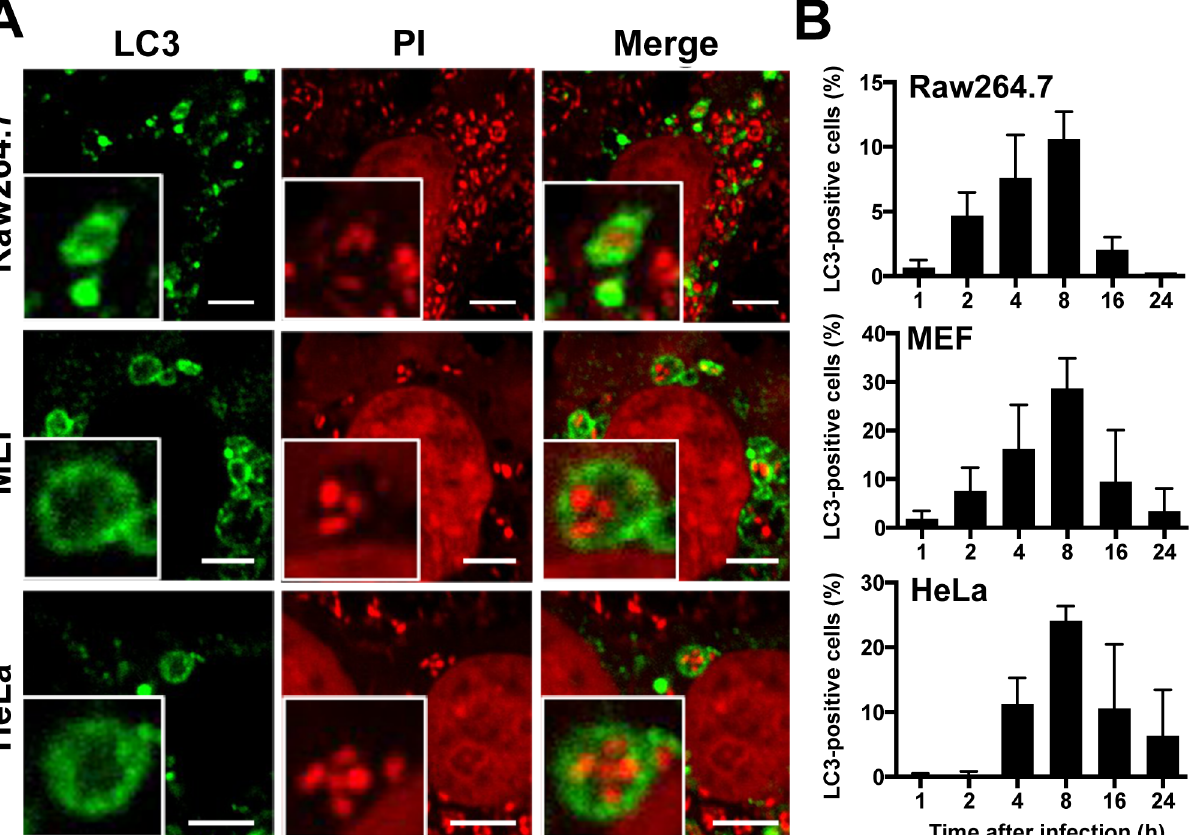
Fig 1. P . acnes in LC3-positive vacuoles. (A) Confocal microscopic image of LC3-positive vacuoles containing P . acnes found in Raw264.7, MEF, and HeLa cells at 8 h MOI 1000 postinfection. Scale bar: 5 μ m. (B) Frequency of cells with LC3-positive vacuoles containing P . acnes at 1, 2, 4, 8, 16, and 24 h MOI 1000 postinfection. Data are representative of at least three independent experiments. Black bars; means +